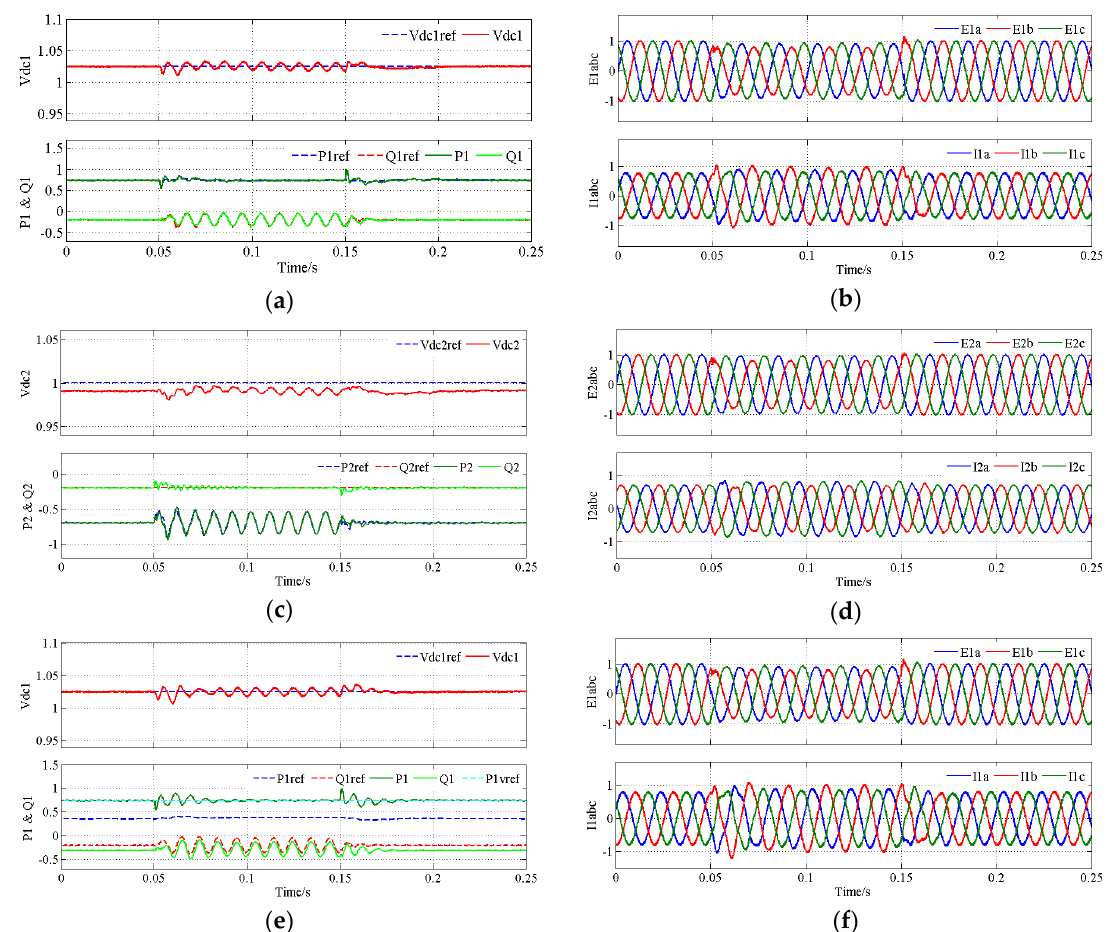
Figure 5. System response to grid voltage unbalance disturbances. ( a ) dc bus voltage, active and reactive power for CS1 by IRSMC DPC controller; ( b ) grid voltage and ac current for CS1 by IRSMC DPC controller; ( c ) dc bus voltage, active and reactive power for CS2 by IRSMC DPC controller; ( d ) grid voltage and ac current for CS2 by IRSMC DPC controller; ( e ) dc bus voltage, active and reactive power for CS1 by RSMC DPC controller; ( f ) grid voltage and ac current for CS1 by RSMC DPC controller.